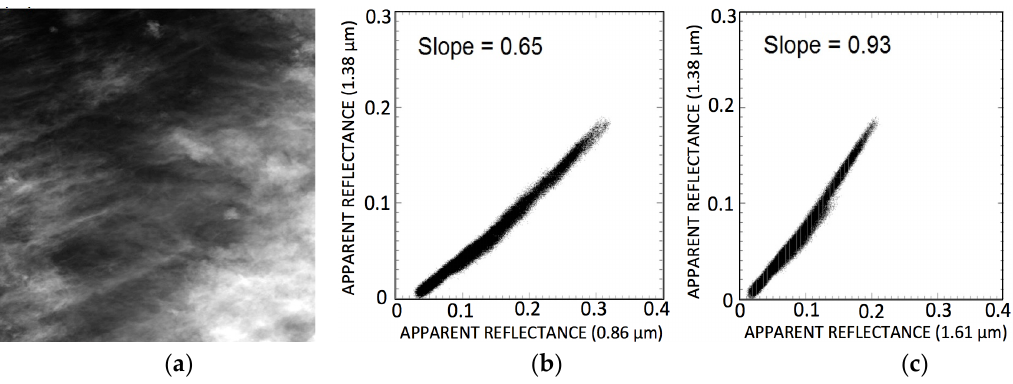
Figure 3. ( a ) An AVIRIS 0.86-μm band image acquired over water surfaces; ( b ) Scatter plot of 1.38-μm band apparent reflectance image versus the 0.86-μm band image; ( c ) Scatter plot of 1.38-μm band apparent reflectance image versus the 1.61-μm band image.